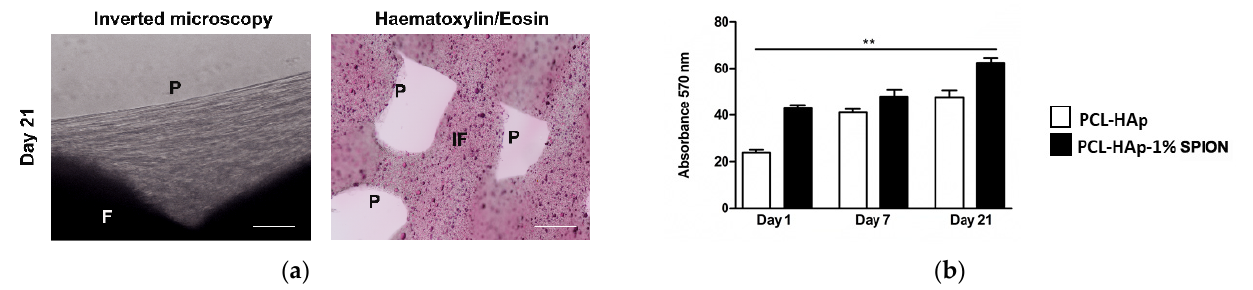
Figure 4. ( a ) Representative images from inverted light microscopy and hematoxylin/eosin staining of MSCs laden-3D PCL-HA-1% SPION at day 21, scale bar:100 µm; P : pores; IF inner filaments; F filaments. ( b ) Alamar blue assay of MSCs seeded onto PCL-HAPs (white bar) and PCL-HAp-1% SPION (black bar) at 1 and 21 days reported as absorbance at 570 nm. ** p < 0.01 MSCs seeded onto PCL-HAp-1% SPION at day 21 versus MSCs seeded onto PCL-HAp at day 1.